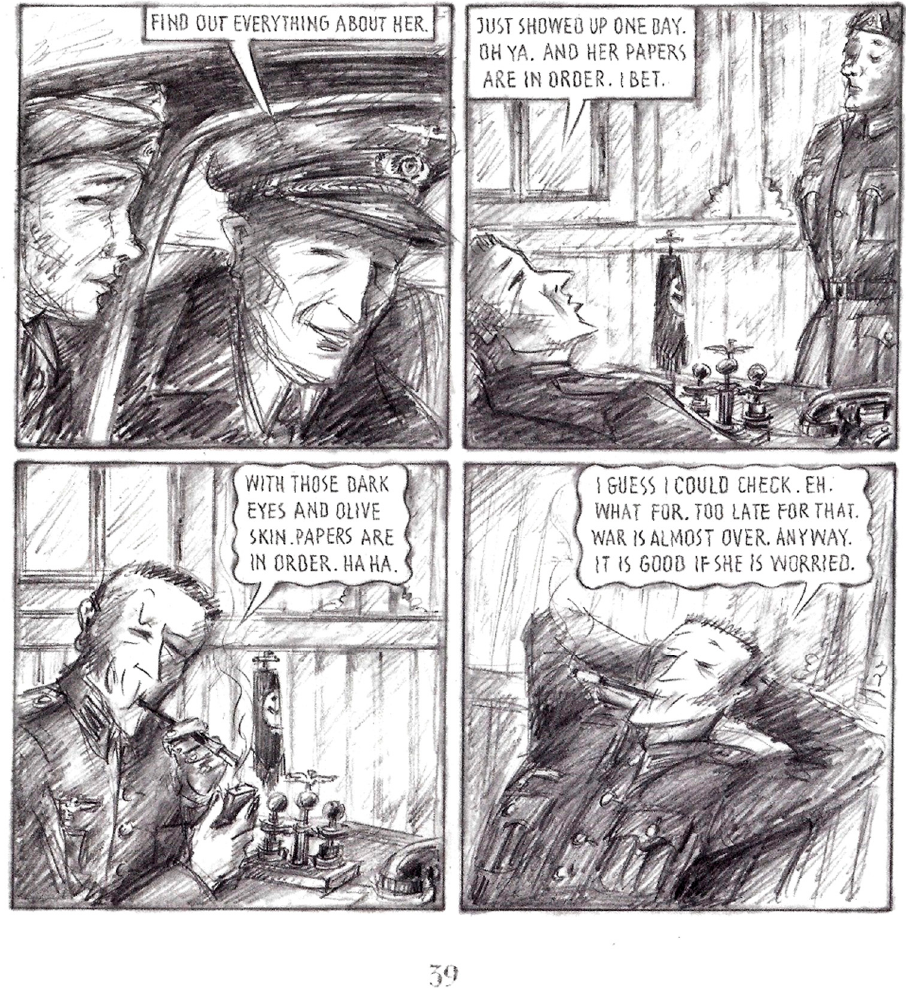
Figure 2. We Are On Our Own (Katin 2006). Reproduced by permission of Miriam Katin.